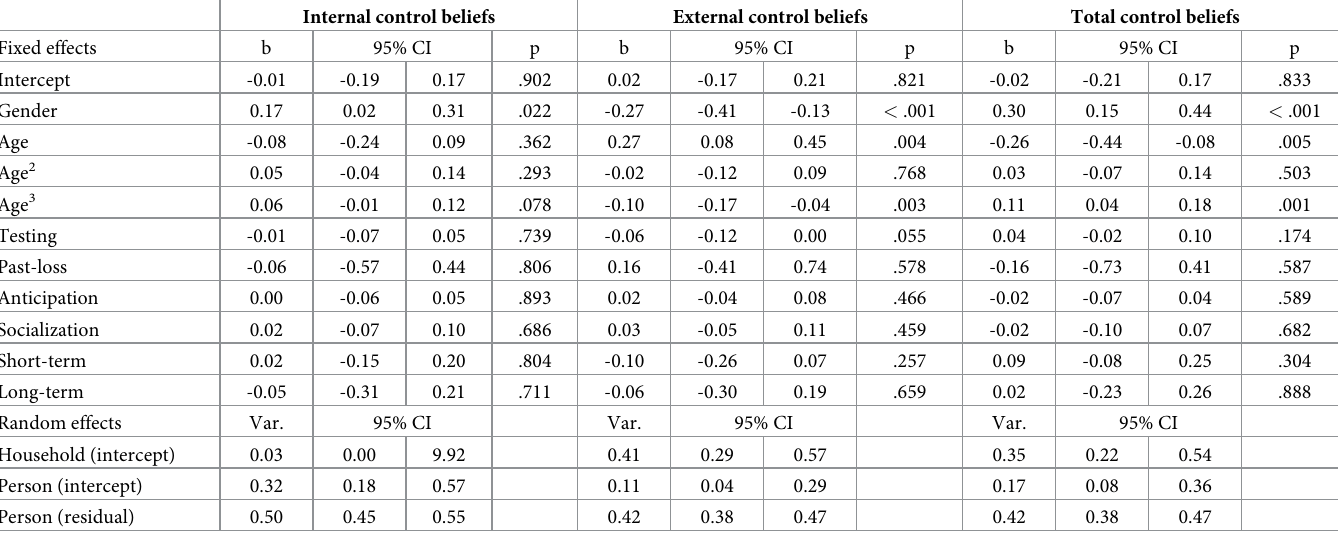
Table 8. Changes in perceived control before and after divorce in individuals who experienced this loss between 1991 and 1999 ( N = 423). Internal control beliefs External control beliefs Total control